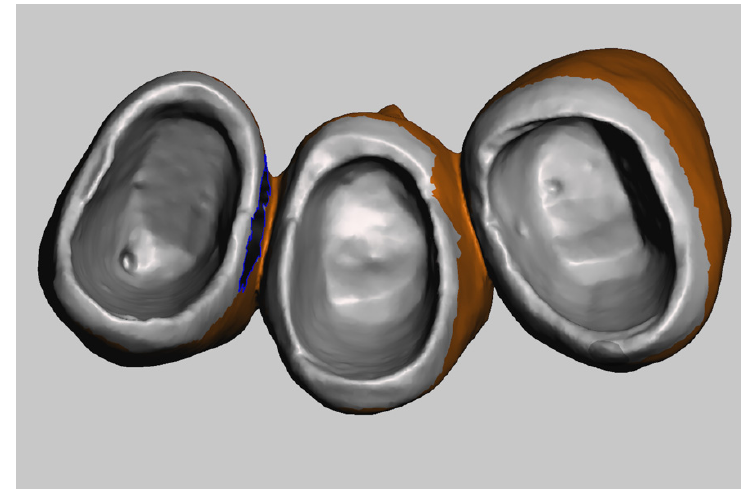
Figure 8. Selection of unnecessary areas.